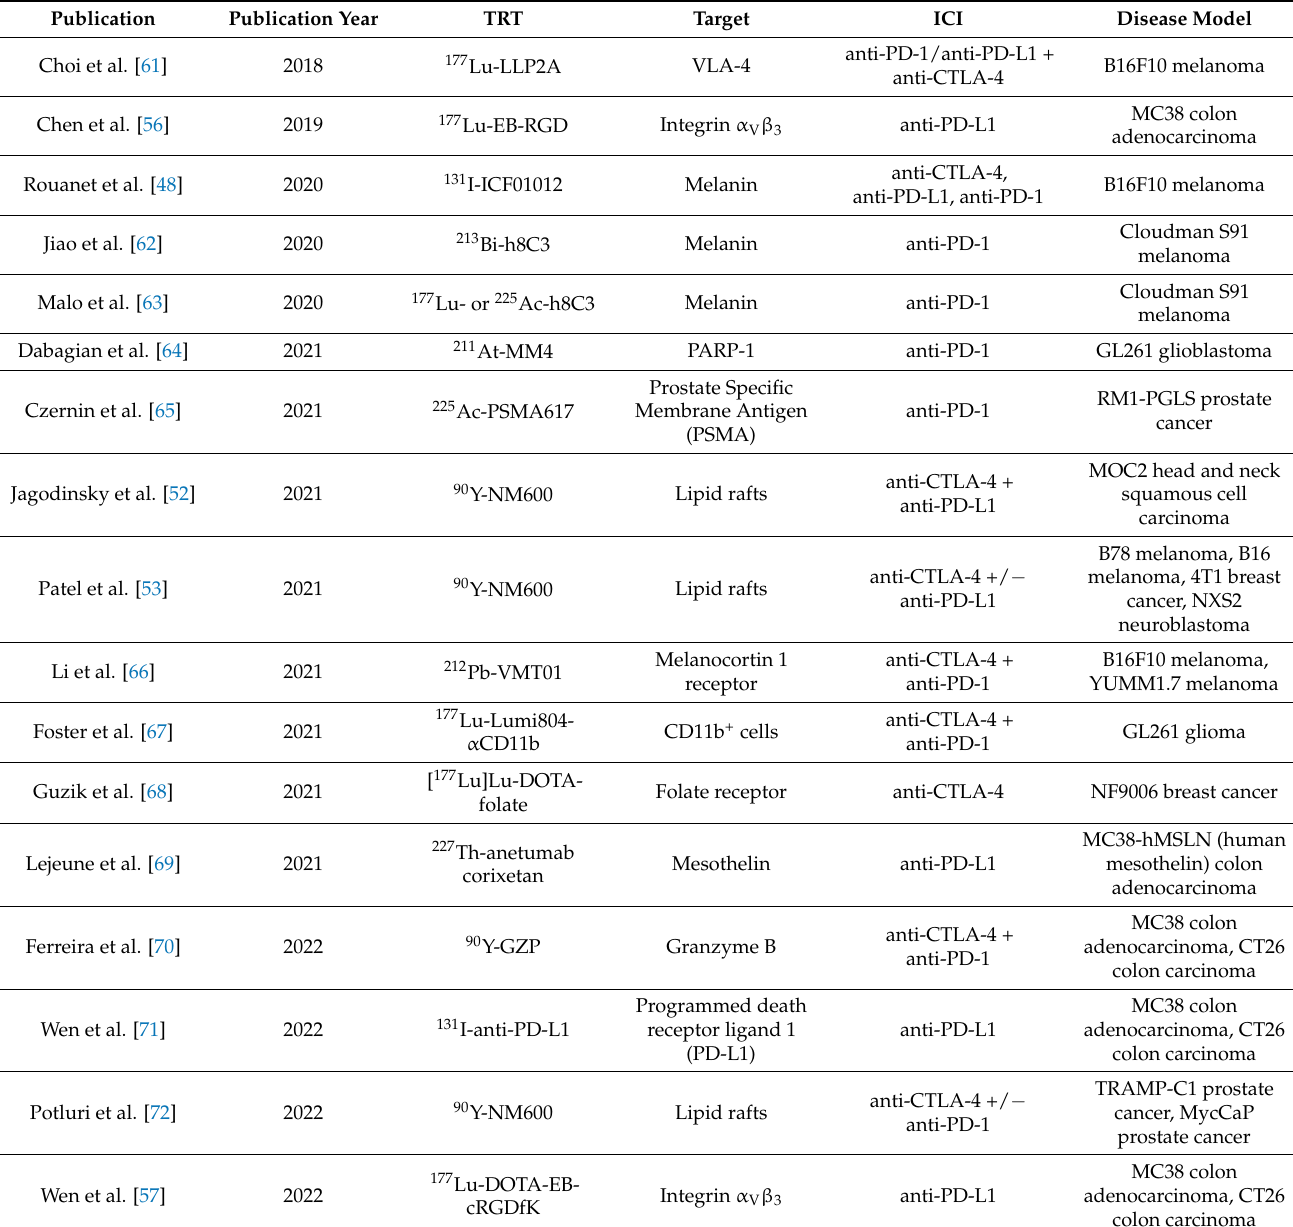
Table 1. Preclinical Combination Targeted Radionuclide Therapy (TRT)-Immune Checkpoint Inhibitor (ICI)